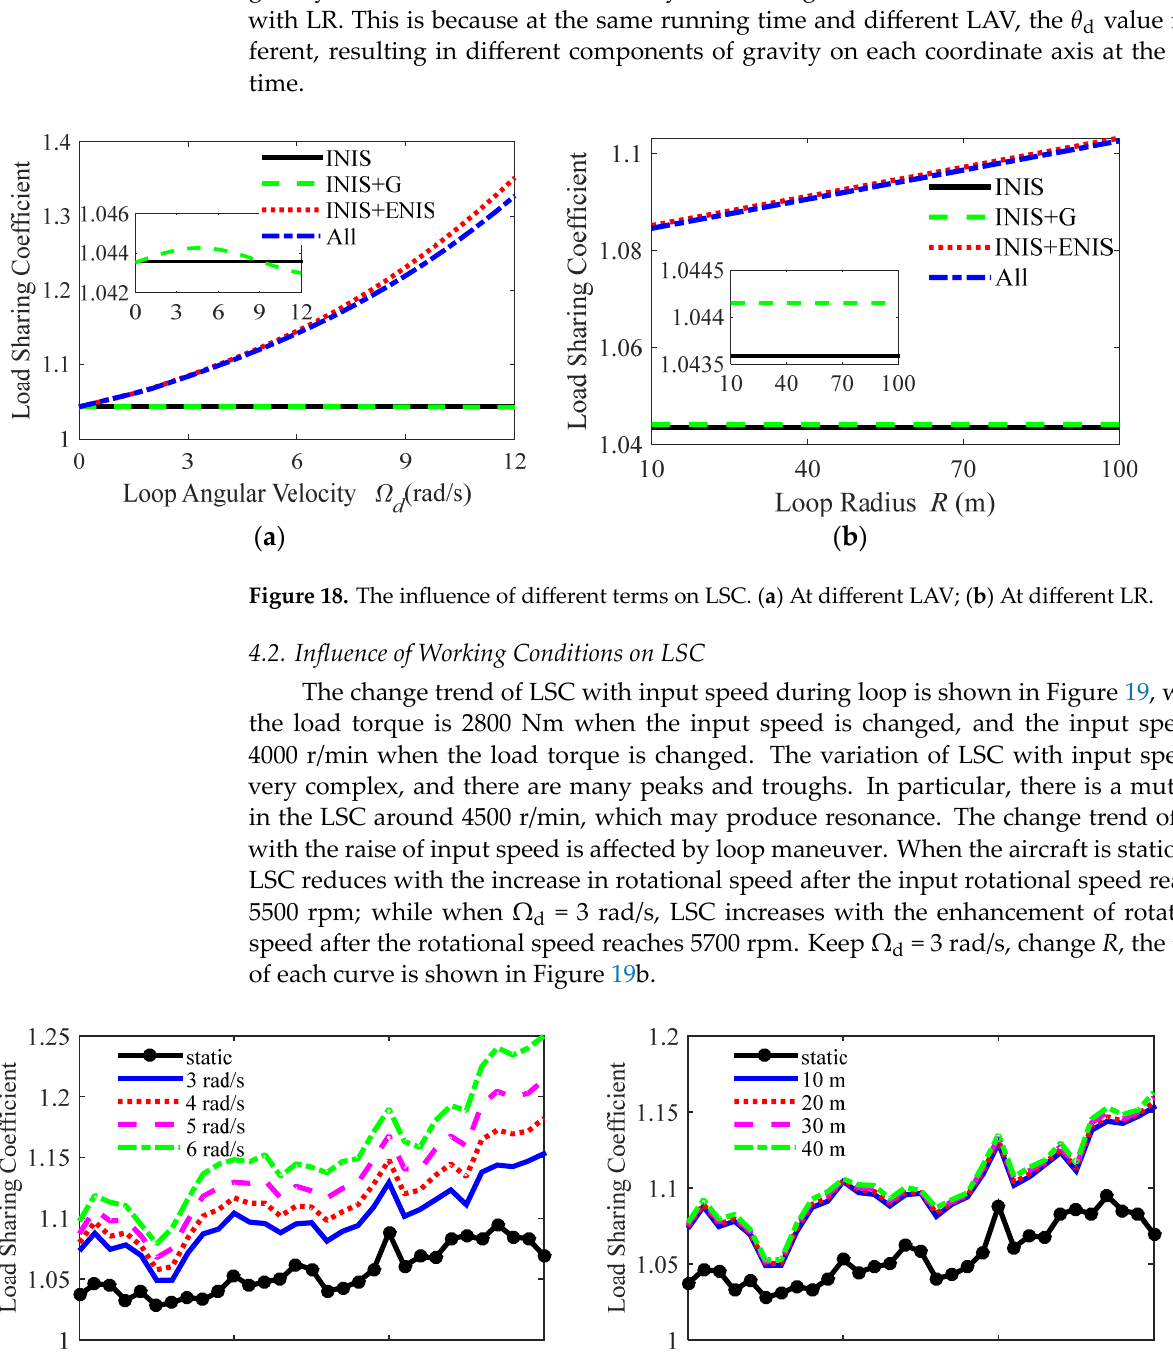
( b ) Figure 17. LSC and dynamic meshing force mean versus different loop motion parameters. ( a ) At different LAV; ( b ) At different LR.